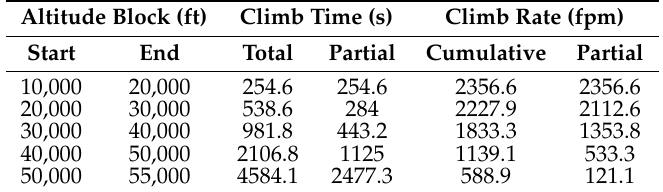
Table 3. Global Hawk total and partial climb rates for Mission 872-0062.